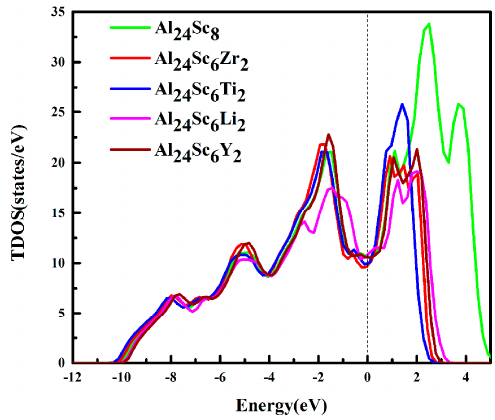
= Sc, Zr, Ti, Li and Y)